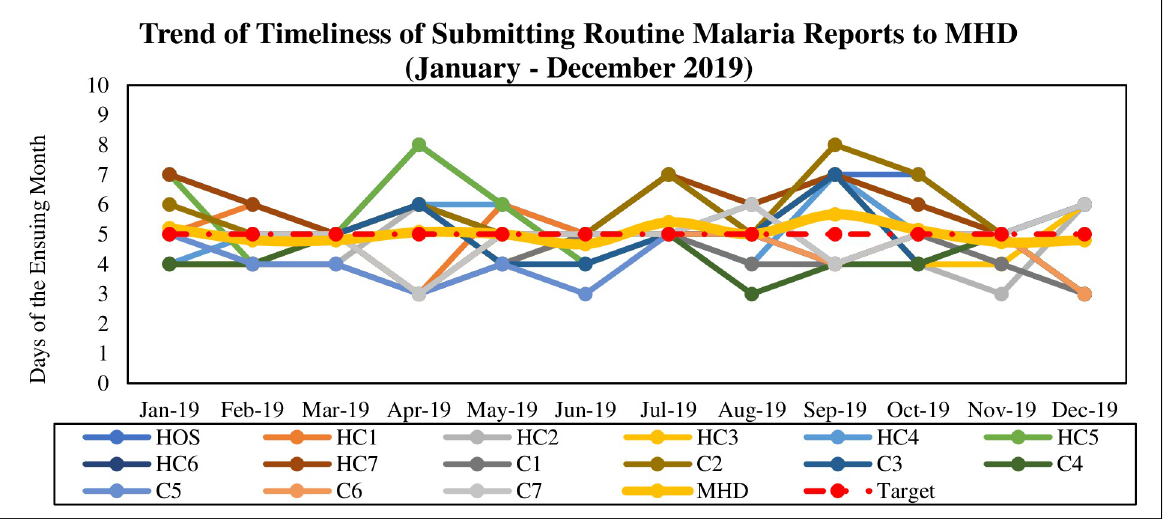
Fig 2. Timeliness of submitting routine malaria reports. Source: Survey, 2021.